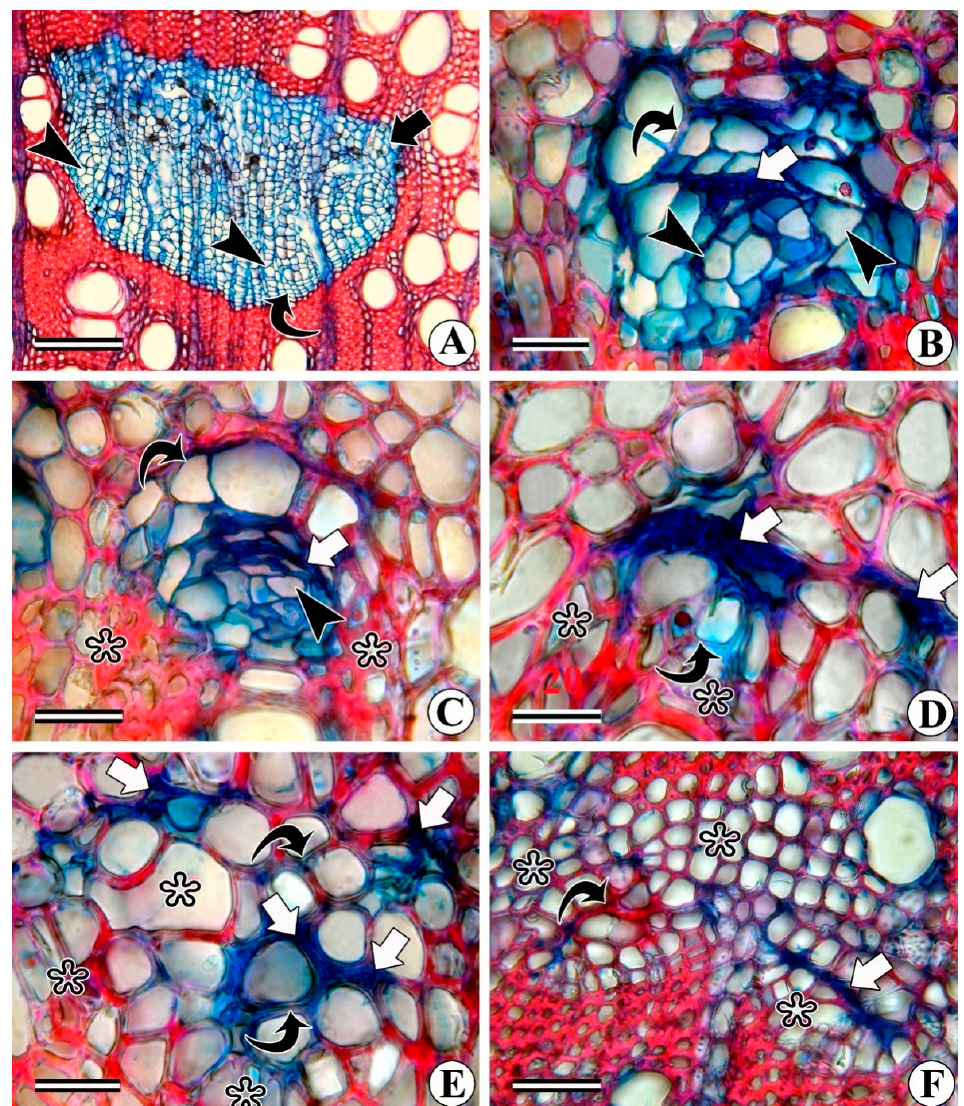
Figure 19. Transverse view of interxylary phloem islands formed at the beginning of the secondary growth stage in different species of eudicots. ( A ) Interxylary phloem island in Strychnos bredemeyeri (arrow). Arrowheads indicate phloem and curved arrow shows cambium. ( B ) One of the previously formed phloem islands in Gallesia integrifolia showing crushed phloem (arrow), sieve elements (arrowheads), and partly lignified cell wall of the adjacent parenchyma cells (curved arrow). Note the loss of radial arrangement of the cambial cells. ( C – E ) Gradual reduction in the size of the interxylary phloem island. Note the crushed phloem (arrow/s) and partly lignified parenchymatous cells (curved arrow). Note the irregular-sized cells (asterisks) that have undergone lignification. ( F ) Completely sealed interxylary phloem island (curved arrow); arrow indicates partially sealed island (note the astra blue staining) and adjacent parenchyma cells (asterisk) that have undergone lignification (curved arrow). Scale bars : A = 100 µm; B–E = 20 µm, F = 50 µm.